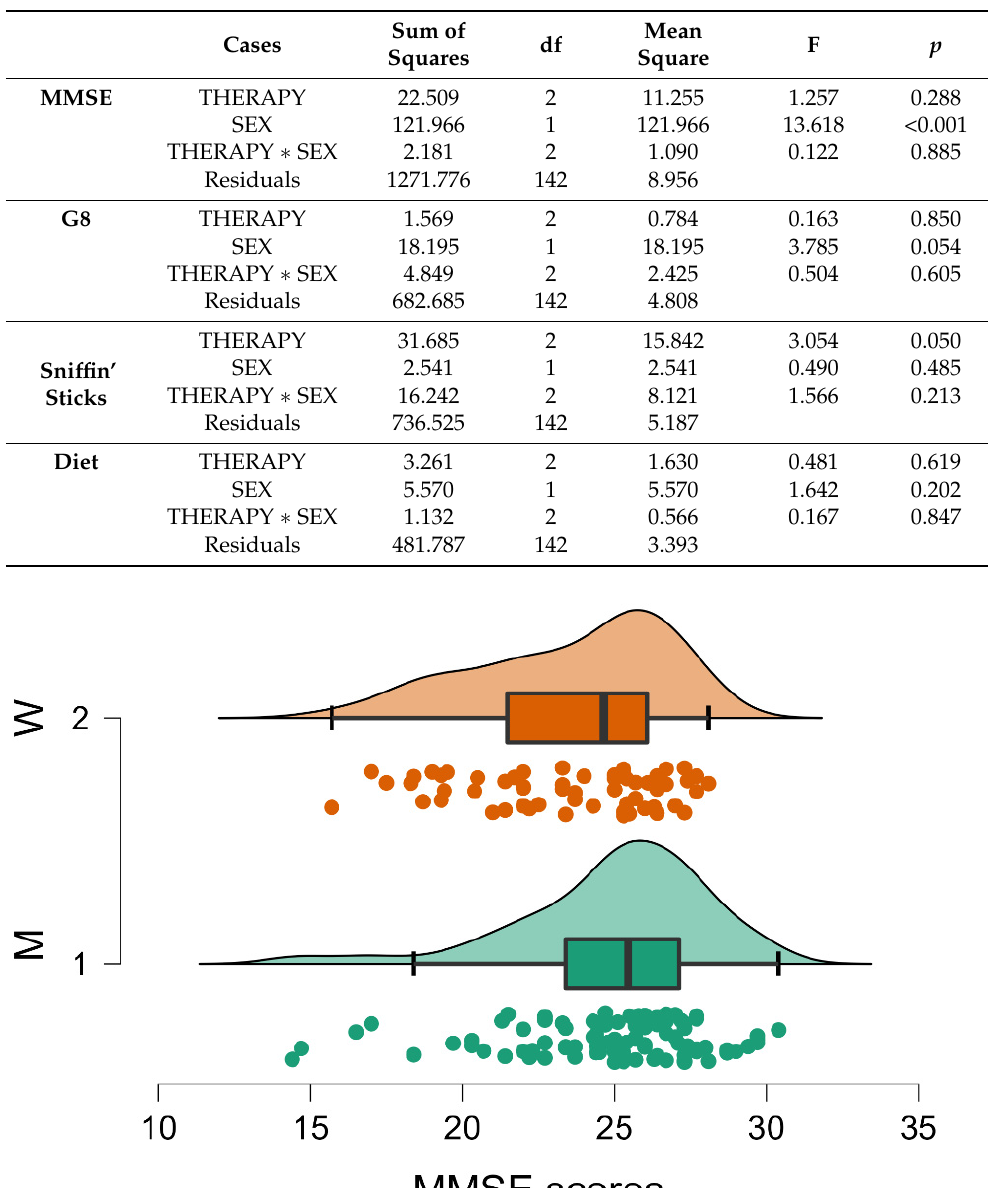
Table 2. Individual ANOVA results per dependent variable (i.e., each single test) showing the significant effect of gender on MMSE performance, the trend on G8 and the significant effect of therapy on the Sniffin’ test.